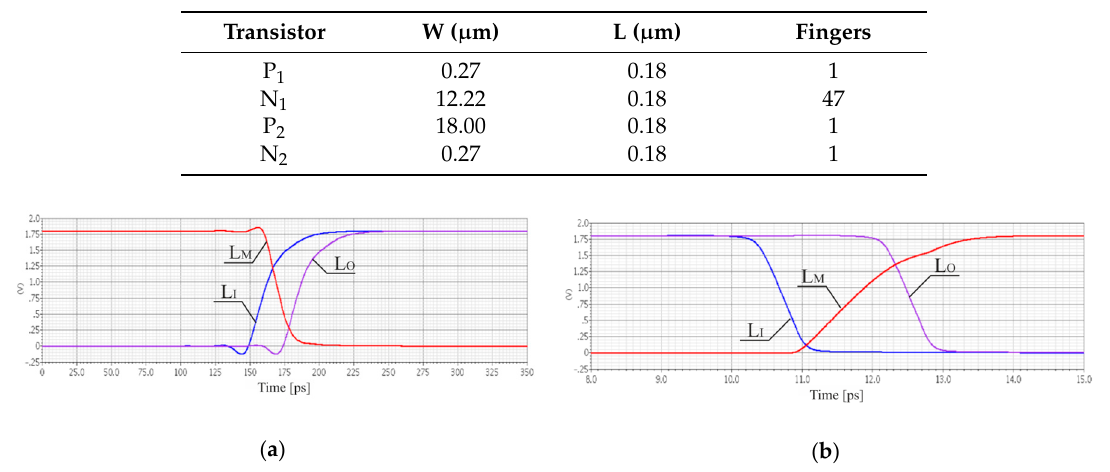
Table 2. Transistors dimensions for asymmetric pair of inverters.